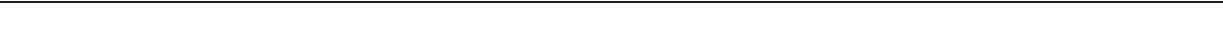
Fig. 6 SIRT3 regulates mitochondrial integrity and tubulin-dependent exchange in injured RPTECs. a Quanti fi cation of mitochondrial fragmentation assessed by MitoTracker staining and b quanti fi cation (red/green fl orescent area) of mitochondrial membrane potential by JC-1 in RPTECs transfected with null small interfering RNA (siNULL) or small interfering for SIRT3 (siSIRT3) and incubated with cisplatin alone or co-cultured with UC-MSCs ( n = 4 independent experiments). Control RPTECs transfected with siNULL were used for comparison. *** P < 0.001 vs siNULL + Control, °°° P < 0.001 vs siNULL + Cispl, and ### P < 0.001 vs siNULL+ Cispl + UC-MSCs using ANOVA corrected with Bonferroni coef fi cient. c Evaluation of citrate synthase activity, d ATP content, and e SOD2 protein expression in RPTECs transfected with siNULL or siSIRT3, and then treated with cisplatin alone or co-cultured with UC-MSCs ( n = 3 independent experiments). Control RPTECs transfected with siNULL were used for comparison. * P < 0.05 and ** P < 0.01 vs siNULL + Control, °° P < 0.01 and °°° P < 0.001 vs siNULL + Cispl, # P < 0.05 and ## P < 0.01 vs siNULL+ Cispl + UC-MSCs using ANOVA corrected with Bonferroni coef fi cient. f Representative images showing that UC-MSCs were incapable to restore tubulin network (green) and SOD2-labeled mitochondria (red) distribution when co-cultured with cisplatin-treated RPTECs silenced for SIRT3 (siSIRT3) in respect to cells transfected with siNULL ( n = 3 independent experiments). Control RPTECs transfected with siNULL were used for comparison. Nuclei are counterstained with DAPI (blue). Scale bar 10 μ m. g Evaluation of citrate synthase activity, h ATP content, and i SOD2 protein expression in RPTECs overexpressing SIRT3 by lipofectamine-mediated transfection with pCMV-hSIRT3-GFP (pSIRT3) in comparison with pCMV6-AC-GFP (pNULL) and then exposed to control medium or cisplatin ( n = 4 independent experiments). * P < 0.05, ** P < 0.01, and *** P < 0.001 vs pNULL + Control; ° P < 0.05, °° P < 0.01, and °°° P < 0.001 vs pNULL + Cispl using ANOVA corrected with Bonferroni coef fi cient. j Representative images of immuno fl uorescence analysis showing that SIRT3 overexpression in RPTECs transfected with pSIRT3 preserved tubulin network (green) and SOD2-labeled mitochondria (red) re-distribution in response to cisplatin as compared to cisplatin-treated cells transfected with pNULL ( n = 4 independent experiments). Nuclei are counterstained with DAPI (blue). Scale bar 10 μ m. Data in a – e and g – i are expressed as mean ±